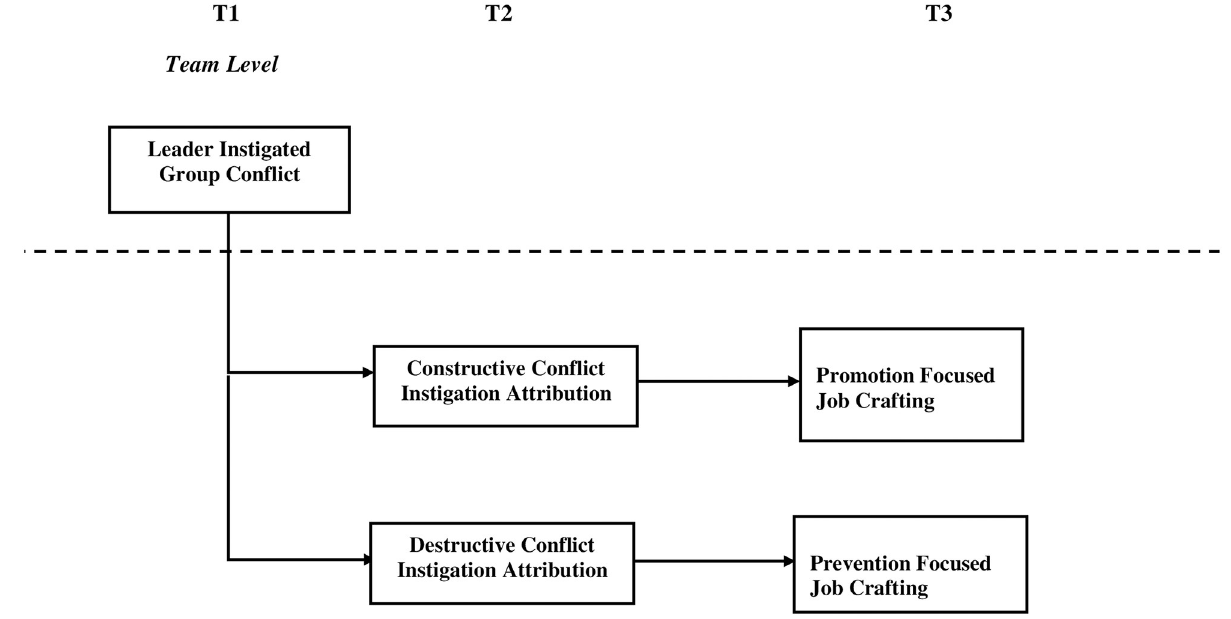
Fig 1. Research model. A multilevel model of leader instigated task conflict, attributions and job crafting.